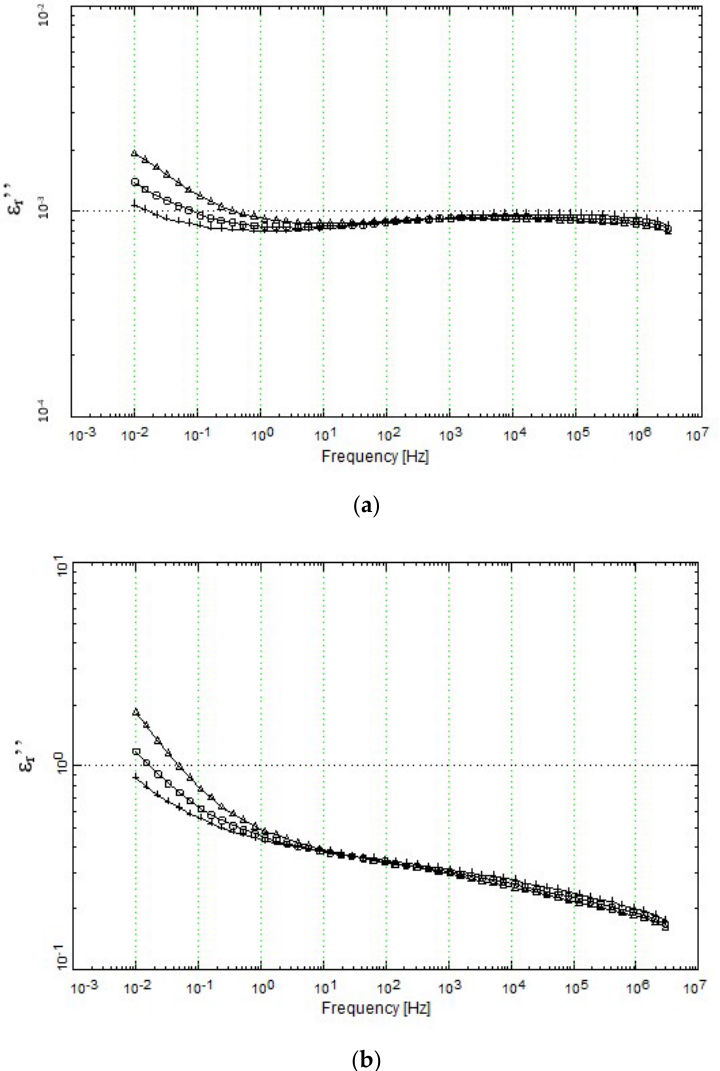
Figure 10. Loss rate of ( a ) neat HDPE and ( b ) HDPE + 40% GTR, as a function of frequency and at di ff erent temperatures. + 35 ◦ C, (cid:3) 50 ◦ C, ∆ 70 ◦